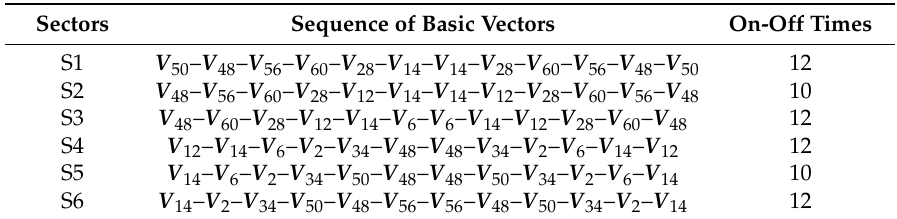
Table 1. Sequence of basic vectors and on-off times.